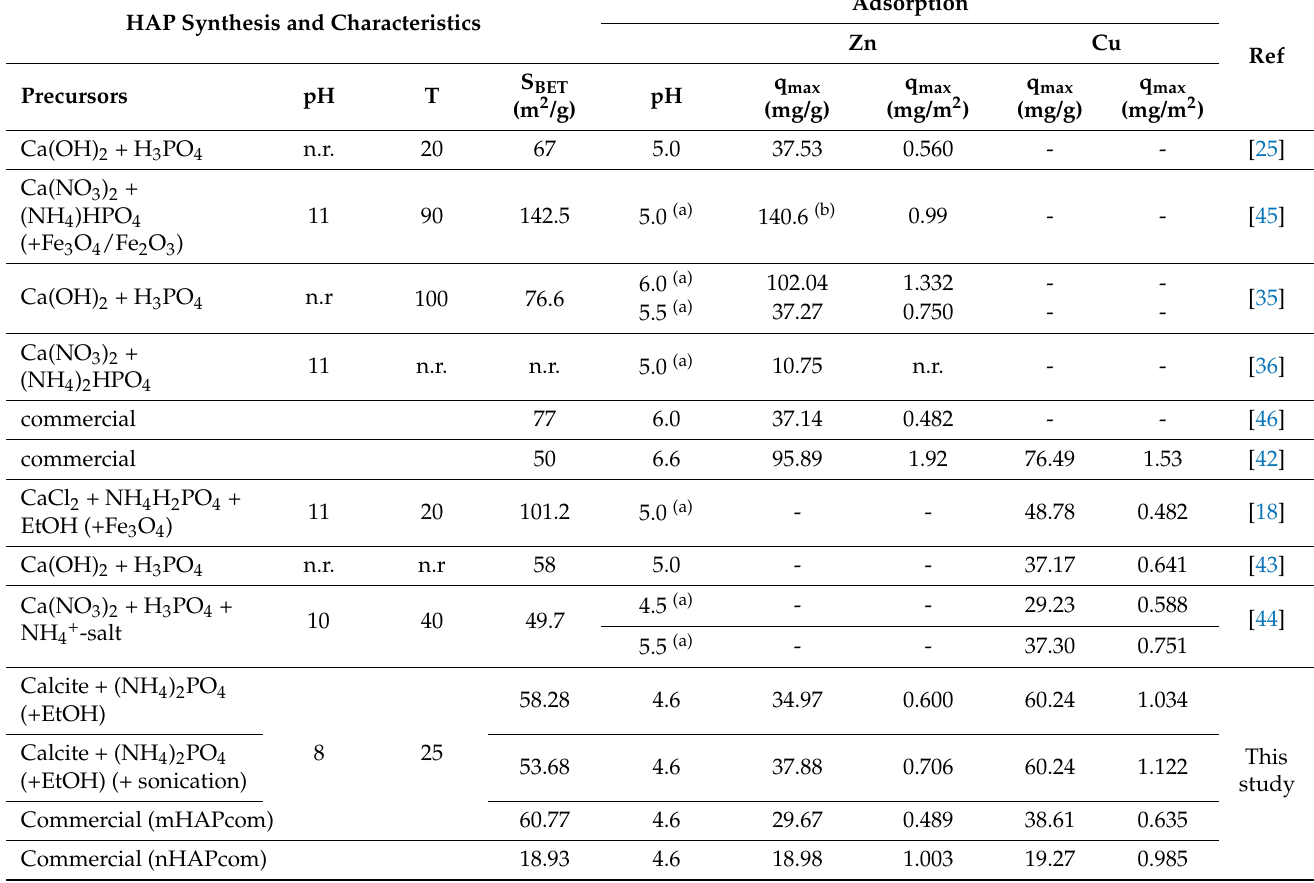
Table 4. Comparison of Langmuir sorption parameters against previous studies with synthesized HAP through wet chemical